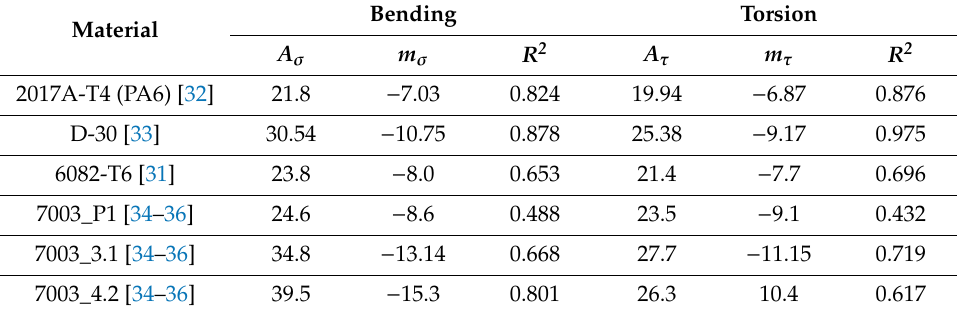
Table 3. Coe ffi cients of regression together with the R 2 parameter of analyzed aluminium alloys.